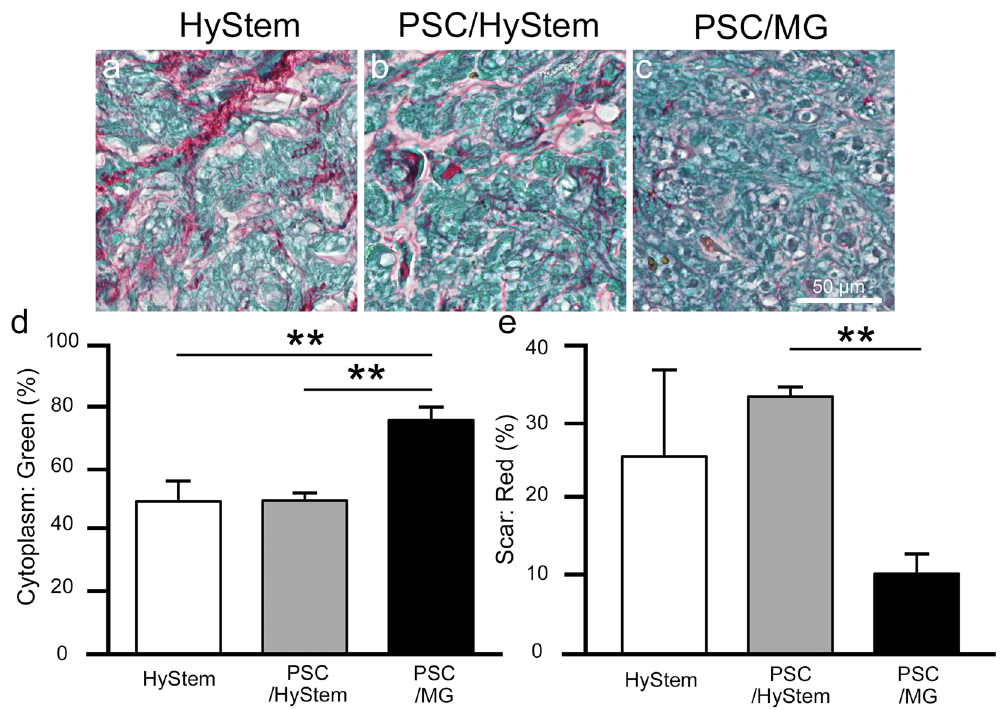
Figure 2. Relative size of the cytoplasm and collagen tissue in the graft area is shown. ( a – c ) High-power images of the graft area with Picro-sirius red staining. ( d ) Fraction of the cytoplasm area shown in green, ** P < 0.01. ( e ) Fraction of the collagen tissue (scar) area, ** P <